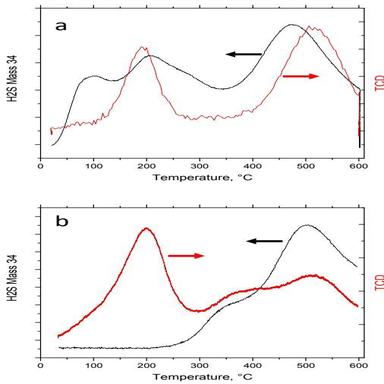
TPR-S experiments for supported 5% Mo/Al2O3 catalyst. (a) Sample pretreated 1h at 400 °C in H2S/H2/argon, then cooled to room temperature prior to TPR-S. (b) Sample pretreated as in a) but purged 30 min in argon at 400 °C before cooling to room temperature for TPR-S. Red curves are TCD output, which primarily reflects H2 (H2 consumption is upward in plots). Black curves are mass spectrometer for H2S (H2S production is upward in plots).